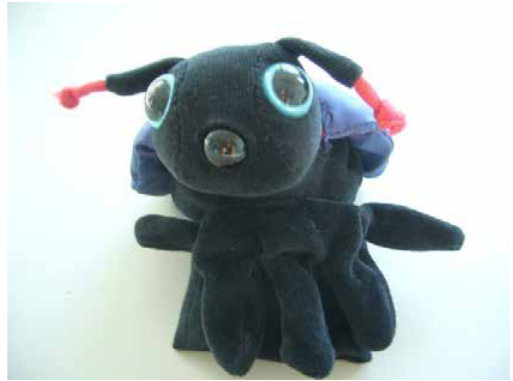
Figure 1 : Dung beetle Marko, the hand puppet in the training programme